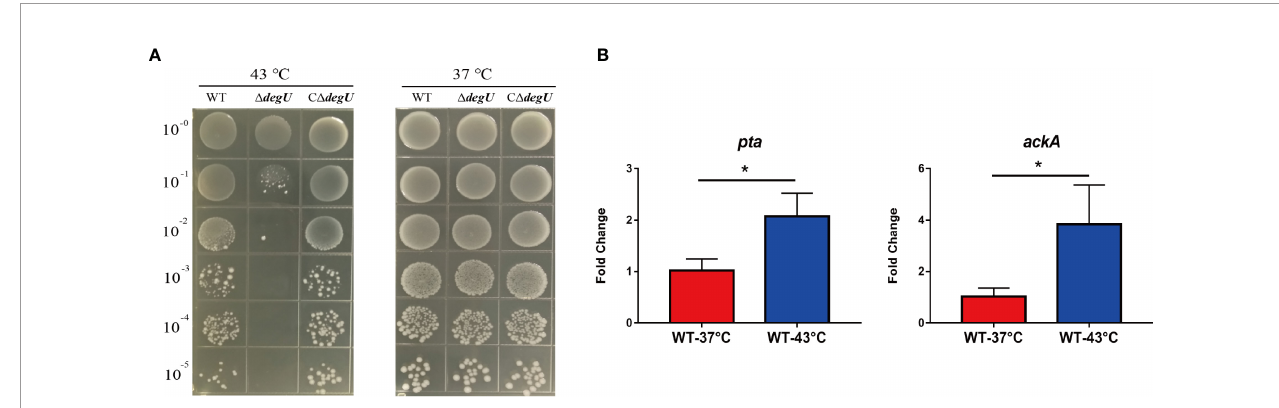
FIGURE 1 | DegUmodulates Listeria monocytogenes responsestoheatstress. (A) Bacterialgrowthunderheat stress.Thewild-type(WT) EGD-e andthe D degUmutant L. monocytogenes werespottedonBHIagar platesusing 10-foldserialdilutionsandincubatedat37°C and43°C. (B) Therelativeexpressionlevelsofthe pta and ackA genes in responsetoheatstress. WT L.monocytogenes EGD-ecellsweregrownat43°C. Dataarepresentedasthe means±S.D. ofthreeindependentexperiments. * p <